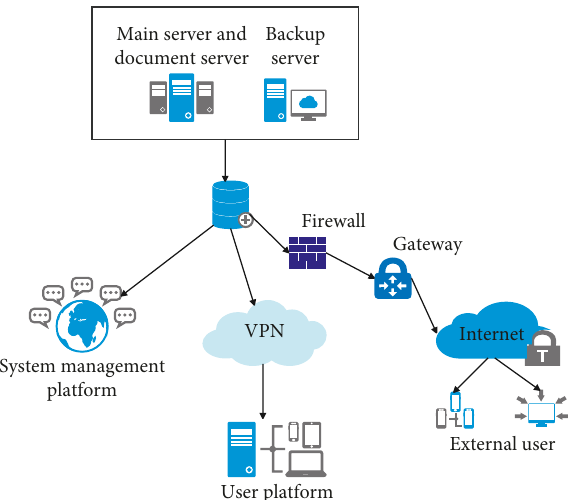
Figure 6: Schematic diagram of network deployment of online teaching resource management system for spoken English in colleges and